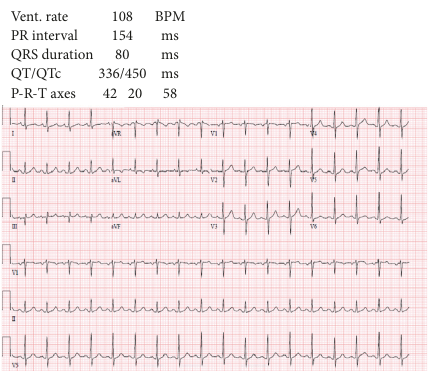
Figure 1: EKG showing sinus tachycardia with S wave in lead I, Q wave in lead III, and electrical alternans.